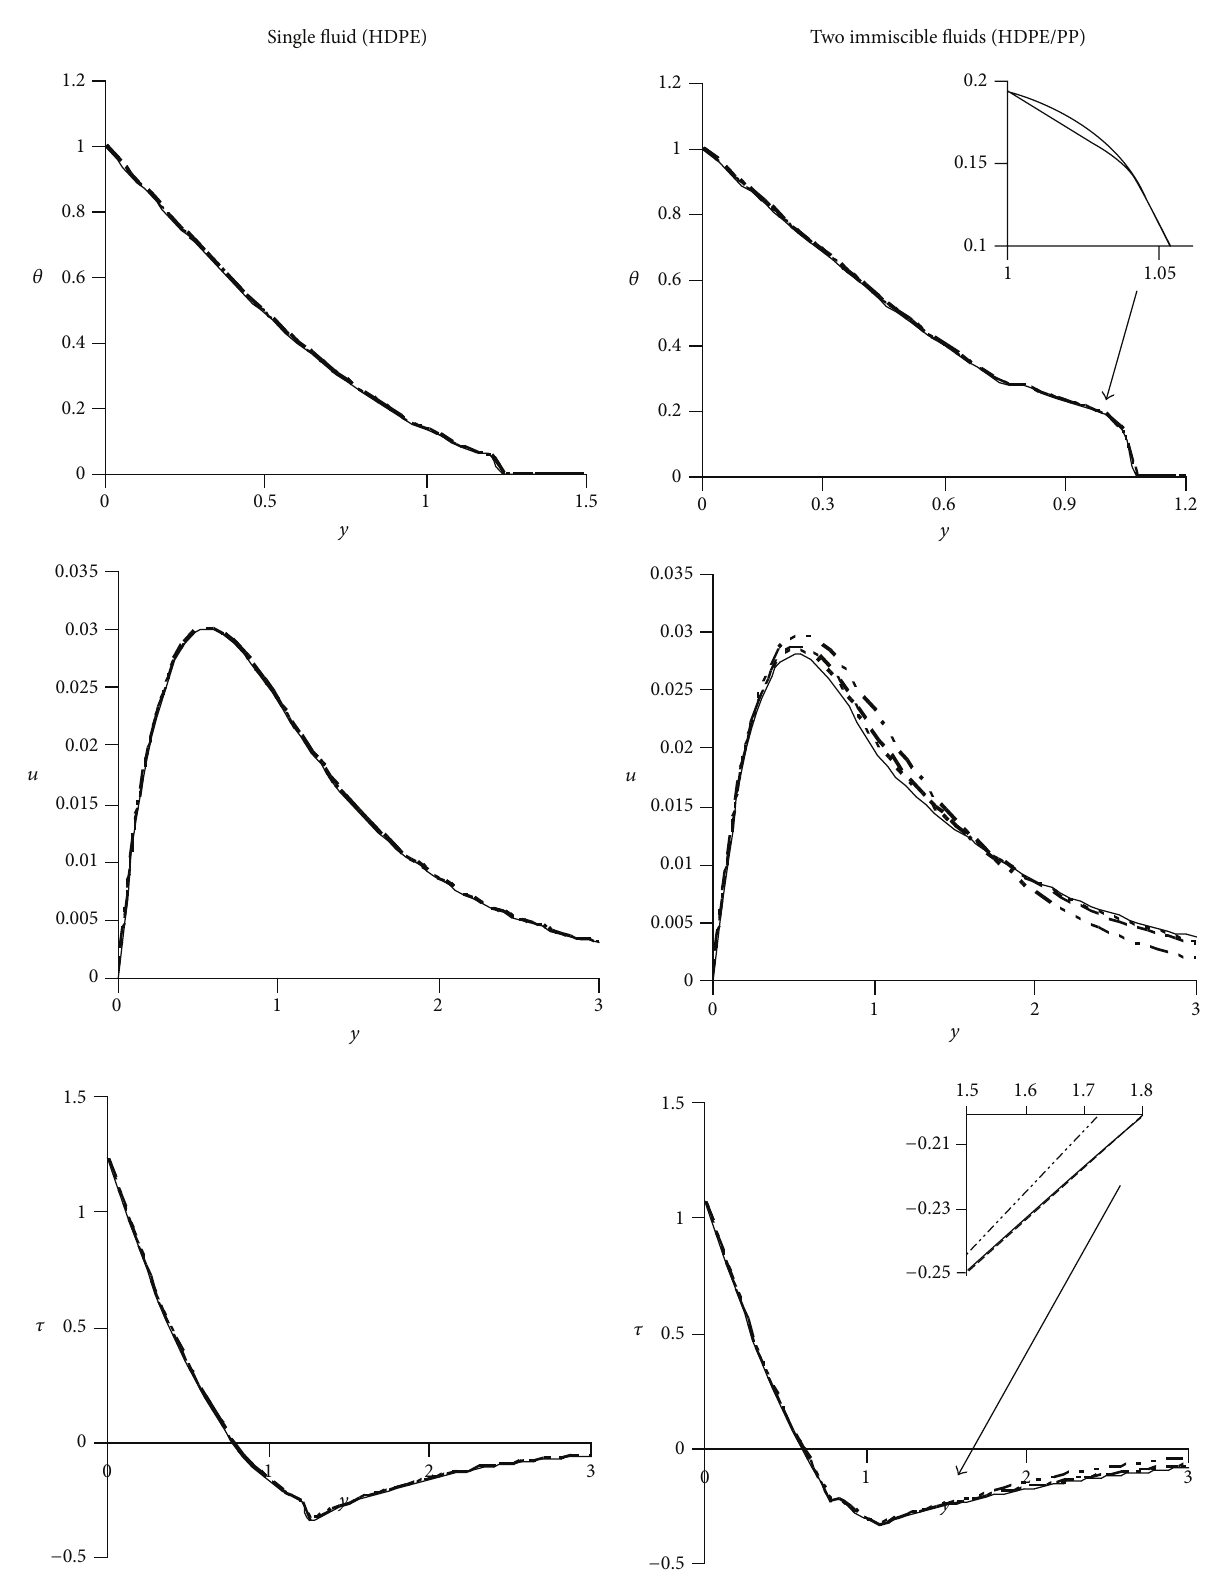
Figure 5: Temperature, velocity, and stress distribution for 𝛼 1 = 𝛼 2 = 𝛽 1 = 1 , 𝑡 = 0.09 , and 𝛽 2 = { 0.0 (– ⋅ ⋅ –); 0.8 (–––); 0.9 ( ⋅ ⋅ ⋅ ); 1.0 (— )}